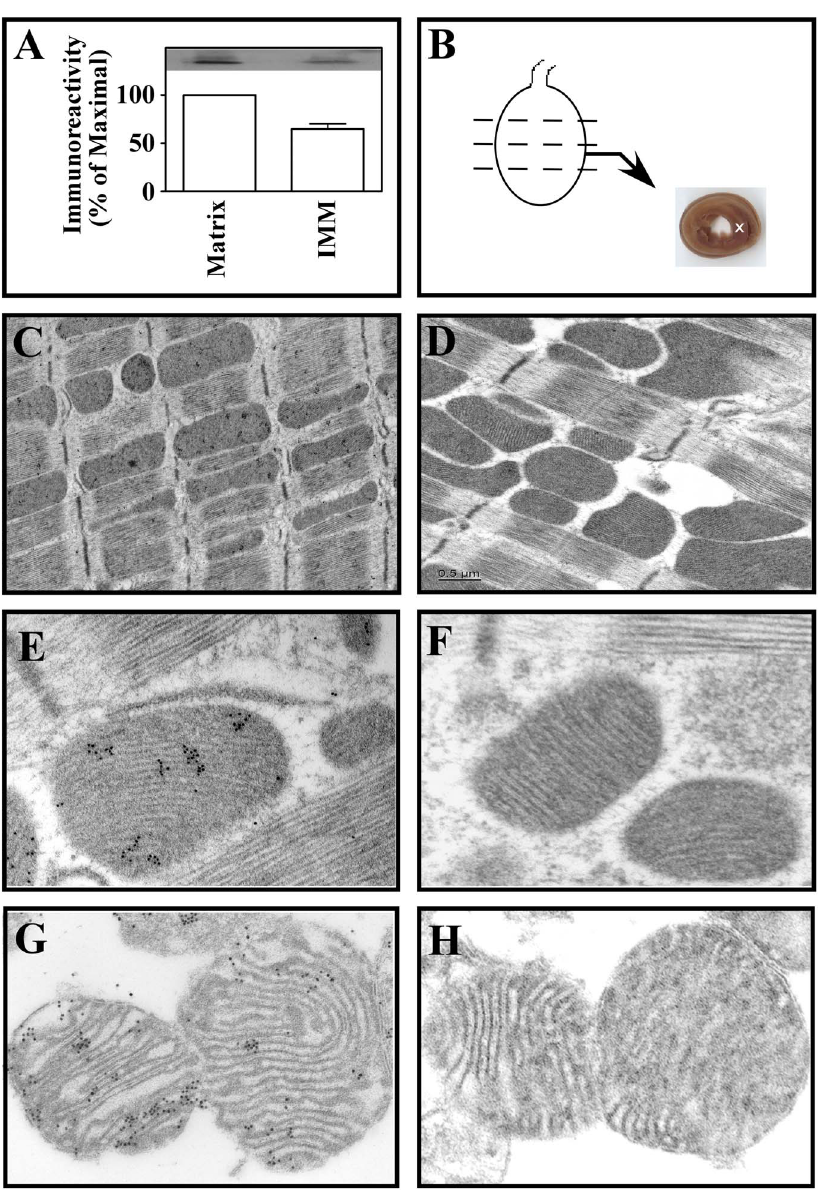
Figure 6. Sub-mitochondrial Localization of the d PKC-dF 1 Fo peptide inhibitor after its perfusion into Langendorff rat hearts. Adult rat hearts were first perfused with 50 nM concentrations of the FLAG-epitope tagged d PKC-dF 1 Fo inhibitor peptide for 1 hr. Hearts were then washed for 5 min with Krebs buffer that contained no peptide. In Panel A mitochondria were then isolated from the left ventricle and subfractionated into mitochondrial inner (IM) and matrix fractions as described in Methods. Sub-mitochondrial fractions were then probed in Western blots with monoclonal mouse anti-FLAG antisera at 1:500 dilution. Results are expressed as the mean 6 S.E. percentage of the maximal densitometry scores from 3 independent experiments. Extensive FLAG immunoreactivity was observed in the matrix and IMM fractions where d PKC would be predicted to interact with the ‘‘d: subunit of F1Fo ATP synthase. Panels B–H refer to results from immuno-gold transmission electron microscopy studies. Results shown are typical analyses conducted in 3 independent experiments in which random fields were selected from embedded sections and a total of 364 mitochondria were analyzed.